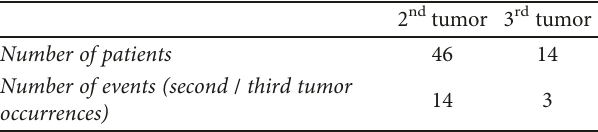
Table 7: Contingency table showing the number of second tumors diagnosed in patients with a bronchial NET and the number of third tumors diagnosed in patients with a bronchial NET and a second tumor.